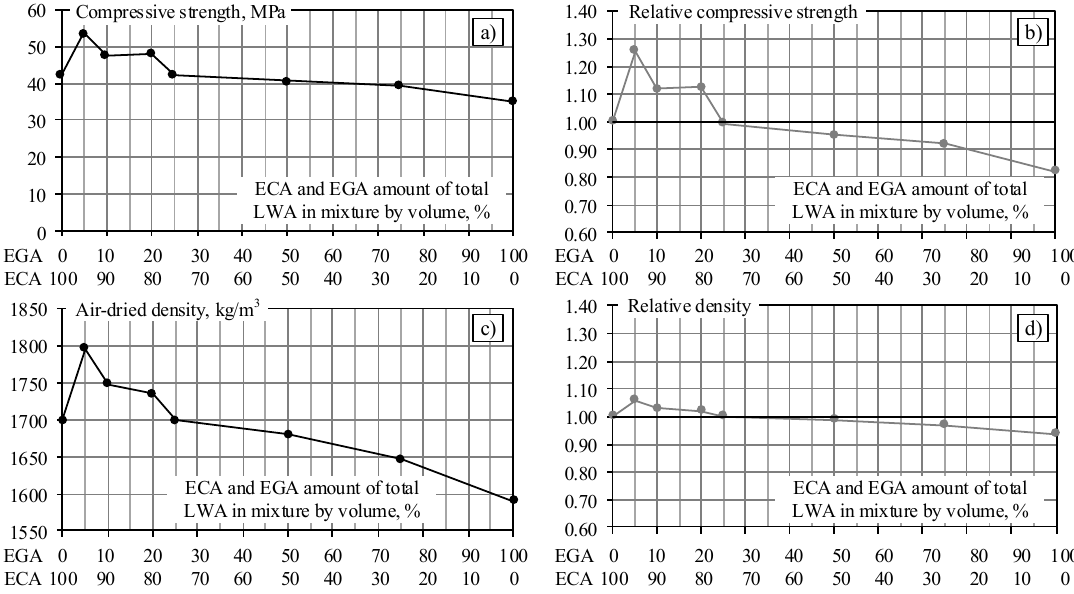
Figure 3. The compressive strength and density of LWAC with mixed LWAs after 28 days of hardening: ( a ) the dependence of compressive strength on the LWA ratio; ( b ) normalised compressive strength; ( c ) the dependence of air-dried density on the LWA ratio; ( d ) normalised